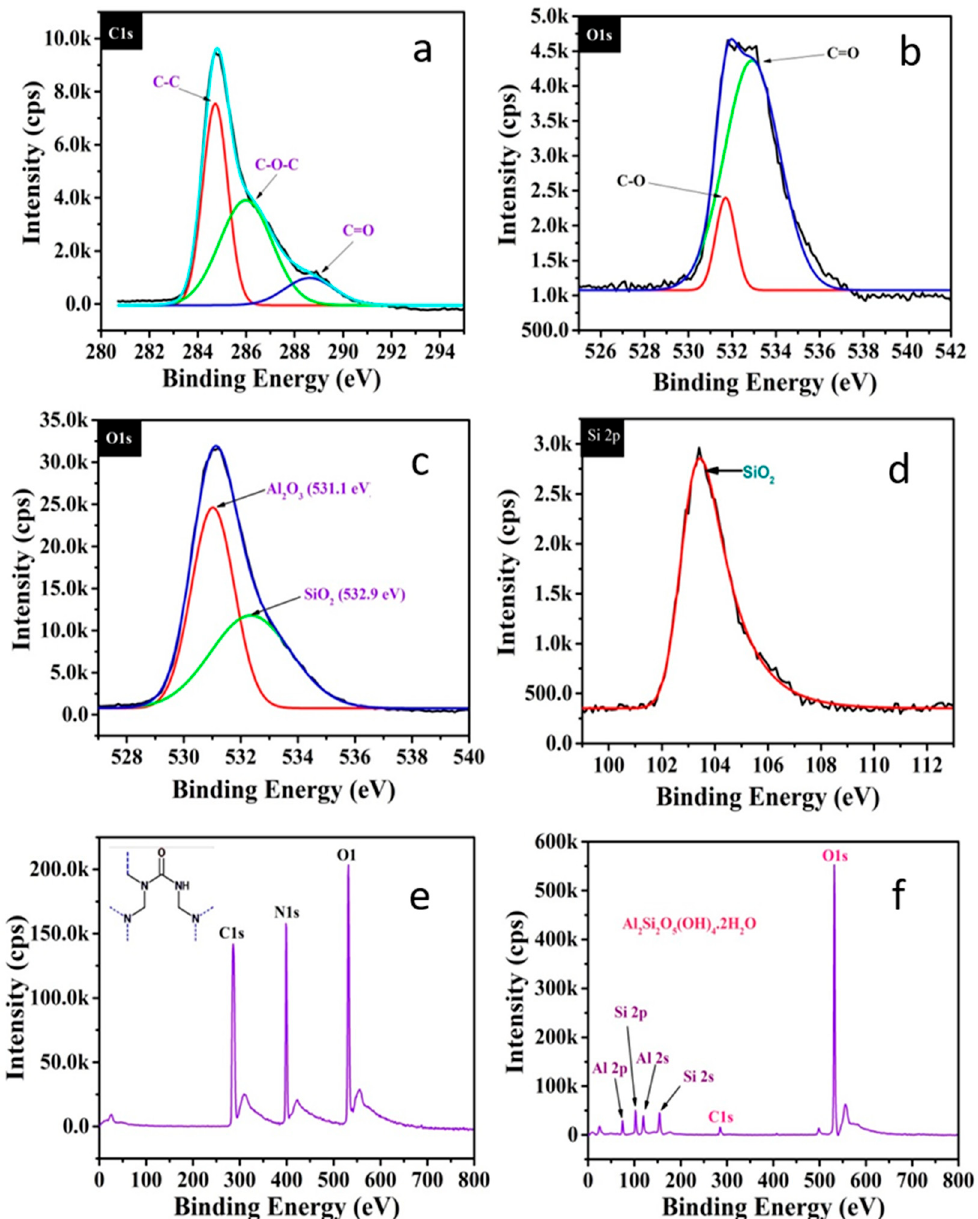
Figure 6. XPS spectra of synthesized containers; ( a , b ) C1s and O1s spectrum of UFMCs, ( c , d ) O1s and Si2p spectrum of HNTs, and ( e , f ) survey spectrum of UFMCs and HNTs.